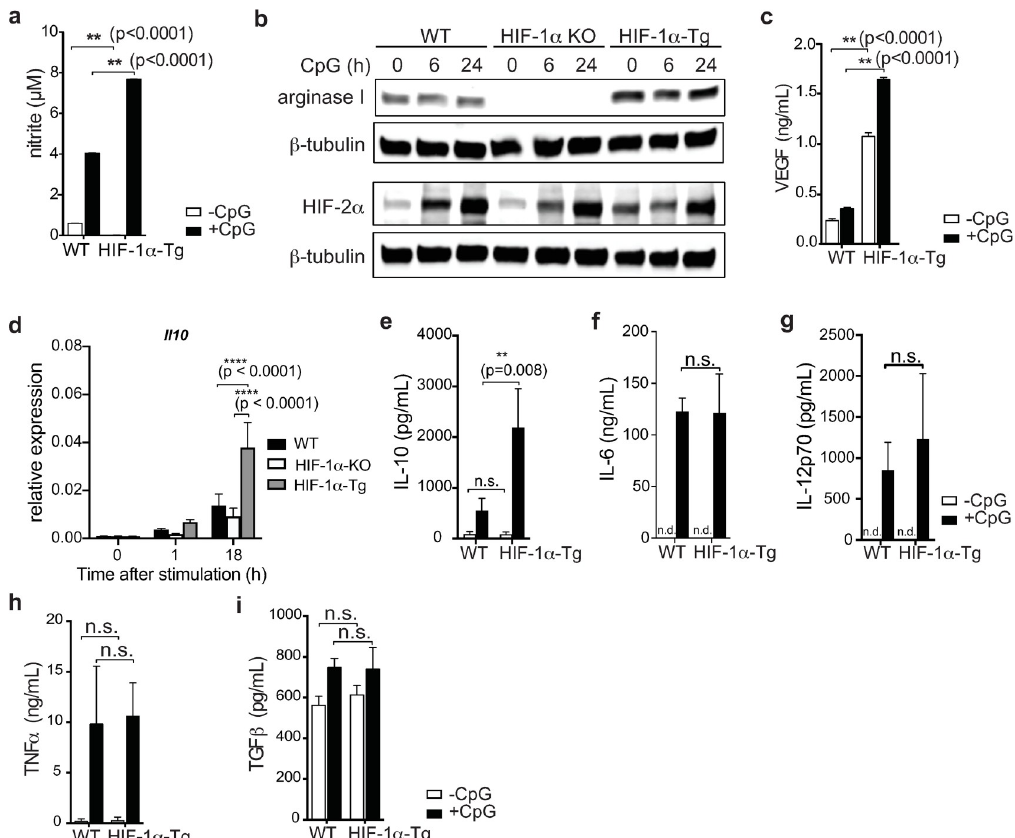
Fig 4. HIF-1 α expression in BMDC cultures promotes the production of immunosuppressive cytokines. ( a ) Nitric oxide production by WT and HIF-1 α -Tg BMDCs was indirectly quantified by measuring nitrite levels (Griess reaction) by ELISA. ( b ) Arginase I and HIF-2 α protein levels in total WT and HIF-1 α -Tg BMDC cell lysates. Cell lysates from the same samples were split across different gels and probed separately for arginase I and HIF-2 α . β -tubulin was used as a protein loading control. ( c ) VEGF production by BMDCs was analyzed by ELISA. ( d ) Il10 expression in BMDCs was analyzed by qPCR before and after CpG-stimulation. ( e ) IL-10, ( f ) IL-6, ( g ) IL-12p70, ( h ) TNF α , and ( i ) TGF β production by BMDCs was analyzed by ELISA. All data are representative of two to three independent experiments. Error bars represent SD of the mean. Statistical testing was performed using two-way ANOVA and Tukey’s test for multiple comparison; n.s.: not significant, n.d.: not detected (below limit of